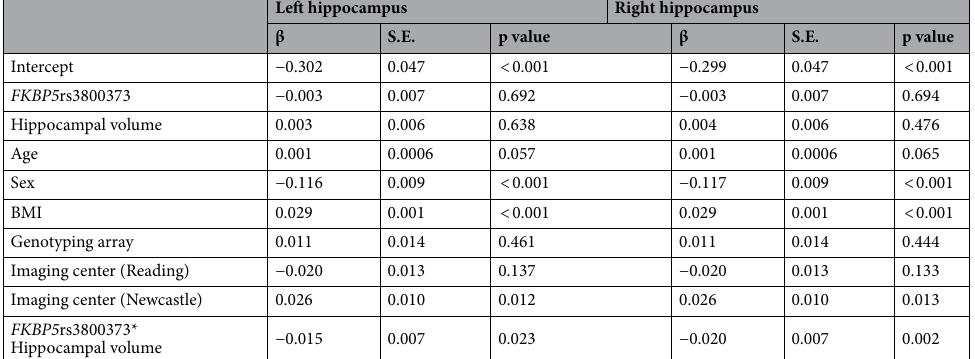
A statistically significant interaction between FKBP5 rs3800373 genetic risk and right hip - pocampal brain volume was associated with CMP severity in UKBB study participants. We next assessed our third hypothesis, that the interaction between FKBP5 rs3800373 and hippocampal brain volume is associated with CMP severity. Here, as shown in Table 2, we found that the interaction between FKBP5 rs3800373 genetic risk and right hippocampal brain volume (β = −0.020, p raw = 0.002, p adj = 0.01), but not left hippocampal brain volume (β = −0.015, p raw = 0.023, p adj = 0.12) was statistically significantly associated with CMP. The interaction explained 0.01% of the variance in CMP. Further, as shown in Fig. 1, we identified a dose-dependent inverse relationship between the number of FKBP5 rs3800373 risk alleles and the relationship between right hippocampal brain volume on CMP severity such that individuals with two FKBP5 rs3800373 risk alleles showed the strongest inverse relationship between right hippocampal volume and CMP (i.e. smaller right hippocampal volume was associated with increased CMP severity; β = −0.031, p = 0.045; Supplementary Table 4). In those individuals with one FKBP5 rs3800373 risk allele, there was a less strong but statistically sig- nificant inverse relationship between right hippocampal volume and CMP (β = −0.016, p = 0.022). Finally in individuals with zero FKBP5 rs3800373 risk alleles, we detected no statistically significant relationship between right hippocampal volume and CMP (β = 0.004, p = 0.639).